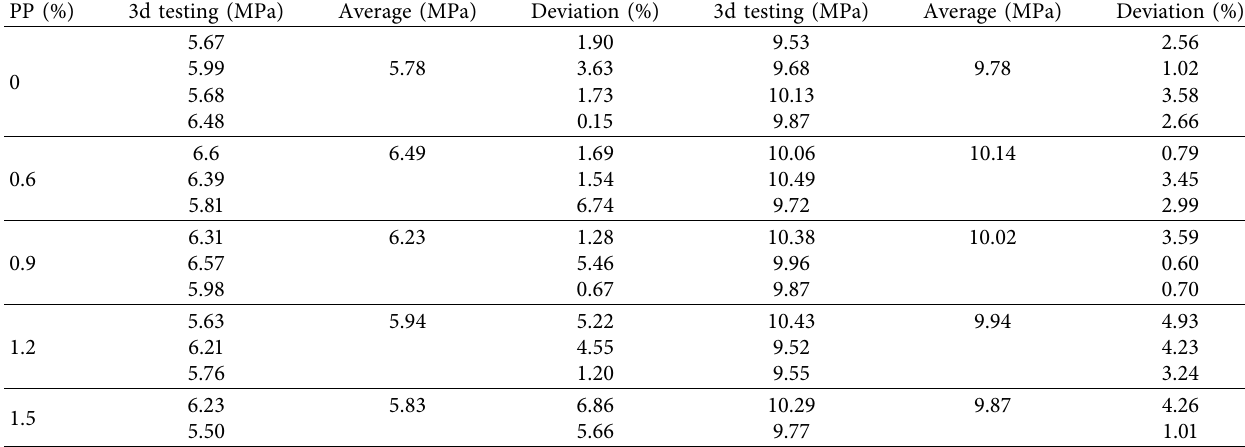
Table 4: Testing results of flexural strengths and their